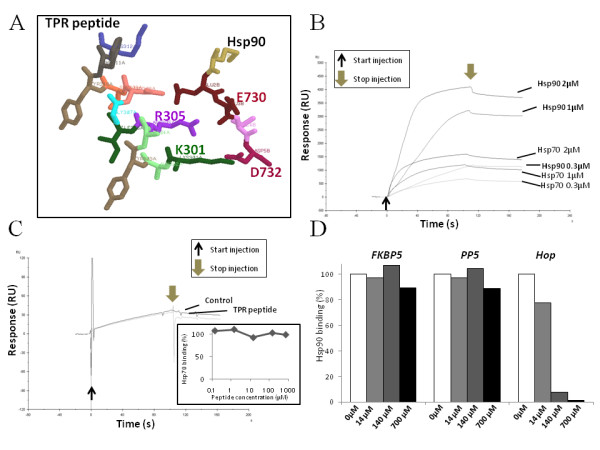
Design and characterization of TPR peptide. (A) Predicted structure of designed TPR peptide. The designed TPR peptide obtained from helix A3 of the TPR2A domain and the bound C-terminal region of Hsp90 are shown with stick model using Ras Mol software. Each number indicates the position of amino acids in Hop or Hsp90 proteins. (B) Sensorgrams of Hsp90 or Hsp70 bound to immobilized TPR peptide as determined using the Biacore biosensor. All analytes (0.3, 1, or 2 μM of Hsp90 or Hsp70) were injected over TPR peptide. The progress of binding to immobilized TPR peptide was monitored by following the increase in signal (response) induced by analytes. The thin and thick arrows indicate the start and stop injection, respectively. RU indicates resonance unit. (C) Competition assay for Hsp70 binding to Hop by TPR peptide. Hsp70 (1 μM) was passed over immobilized Hop in the absence (Control) or presence of TPR peptide (700 μM). The SPR signal in the absence of competing peptides was used as a reference (100% binding). Thin and thick arrows indicate start and stop injections, respectively. Equilibrium response levels obtained in the presence of competing peptides - TPR peptide was normalized and plotted against the peptide concentrations as described in the Materials and Methods section (inset graph). (D) Competition for Hsp90 binding to Hop, FKBP5, or PP5 with TPR peptide. Hsp90 (1 μM) was passed over immobilized Hop, FKBP5, or PP5 in the absence or presence of increasing concentrations of TPR peptide (14, 140, or 700 μM). The SPR signal in the absence of competing peptides was used as a reference (100% Hsp90 binding).